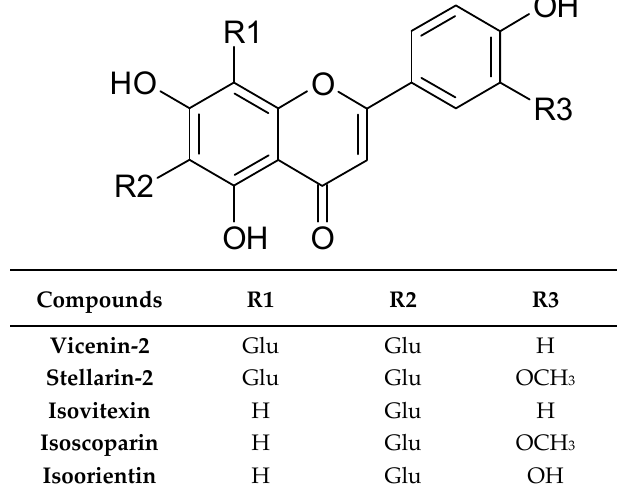
Figure 5. Chemical structure of representative flavonoids of I. tinctoria L.